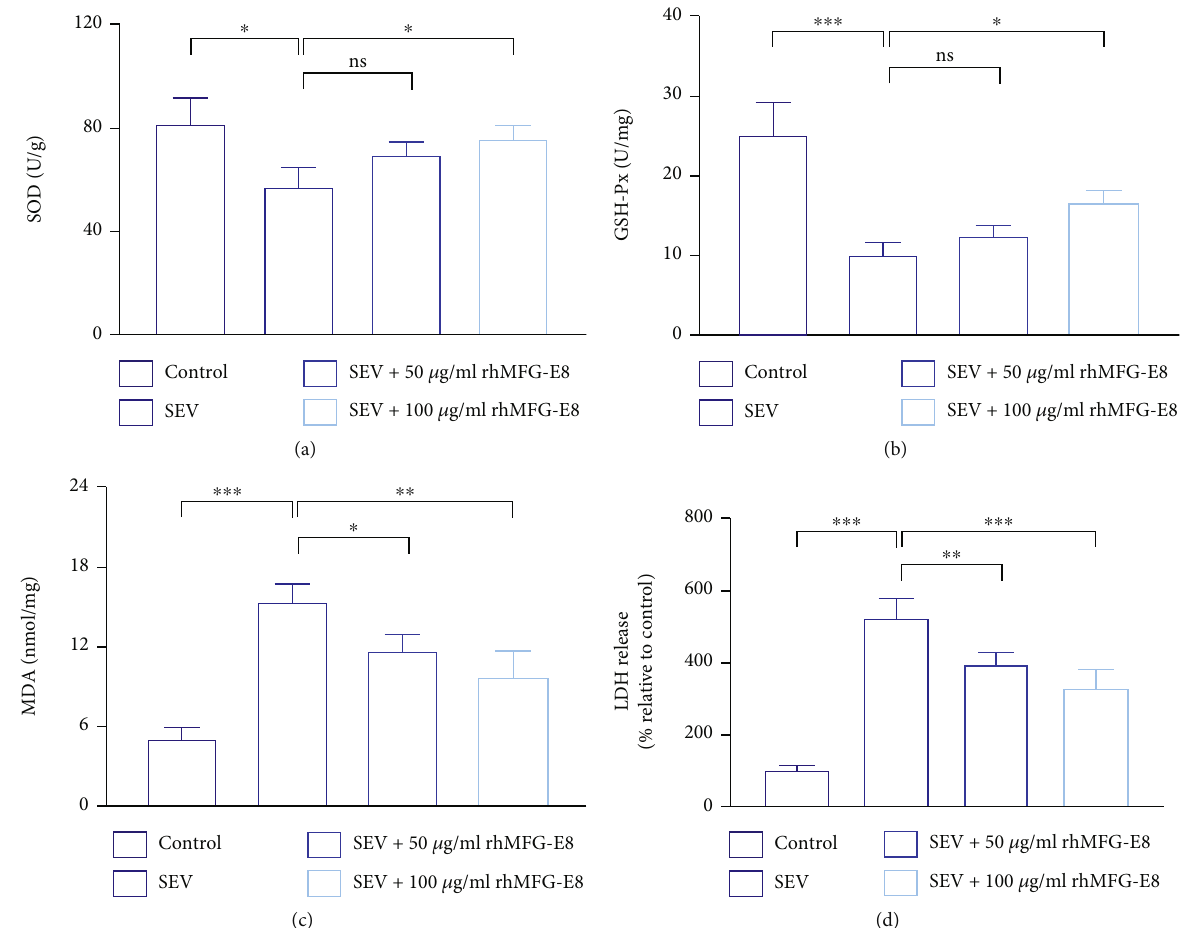
Figure 4: The study of the mechanism of rhMFG-E8 in fl uencing the protein expression related with oxidative stress in NSCs after culture induced by sevo fl urane, sevo fl urane+50 μ g/ml rhMFG-E8, and sevo fl urane+100 μ g/ml rhMFG-E8. (a) The expression of SOD was detected by ELISA. (b) The expression level of GSH-Px was tested by ELISA. (c) The expression of MDA was detected by ELISA. (d) The LDH release measured by kit. ∗ p < 0 : 005 , ∗∗ p < 0 : 001 , ∗∗∗ p < 0 : 0001 .